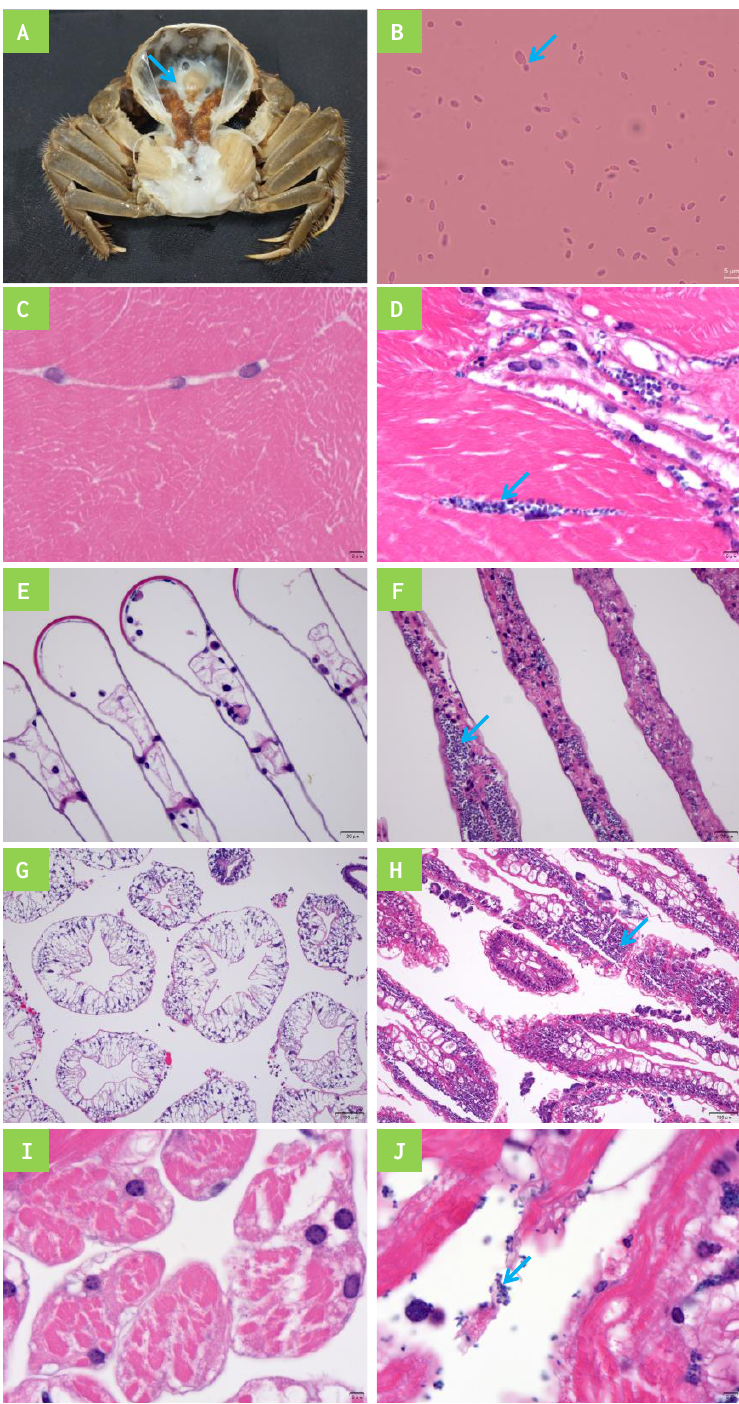
Figure 2. Symptoms and tissue sections after Metschnikowia bicuspidata infection. ( A ) Infected crab symptoms; the arrow shows typical milky body fluid. ( B ) A tissue smear of an infected crab; the arrow indicates budding (1000 × ). ( C , D ) A muscle tissue section of uninfected and infected crabs, respectively; the arrow indicates an accumulation of yeast in a broken fiber gap (1000 × ). ( E , F ) A gill tissue section of uninfected and infected crabs, respectively; the arrow indicates yeast within the branchial lamellar vasculature (400 × ). ( G , H ) A hepatopancreas tissue section of uninfected and infected crabs, respectively; the arrow indicates an accumulation of yeast in the hepatopancreatic tubules (100 × ). ( I , J ) A heart tissue section of uninfected and infected crabs, respectively; the arrow indicates an accumulation of yeast in the broken myocardial fibers (1000 ×